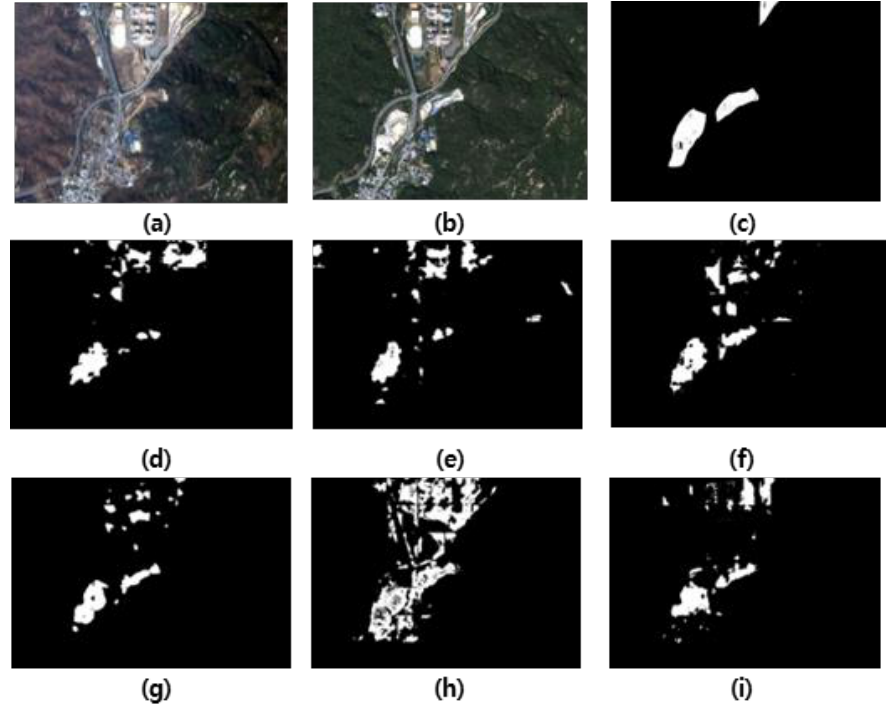
Figure 17. Changed detection maps of the proposed and conventional algorithms for “Test area 3” for the reverse input order: ( a ) Image P; ( b ) Image C; ( c ) Ground truth; ( d ) DI + UNet; ( e ) DI + ATTUNet; ( f ) JF + UNet; ( g ) JF + ATTUNet; ( h ) Modified-UNet++; ( i ) Proposed bilateral U-Net.